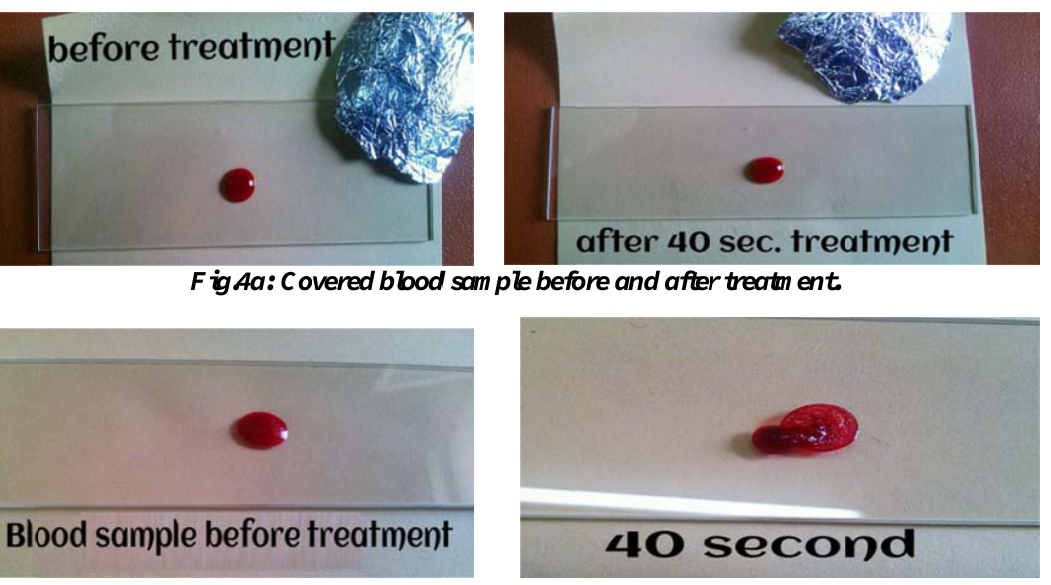
ig. 4b: The u samples